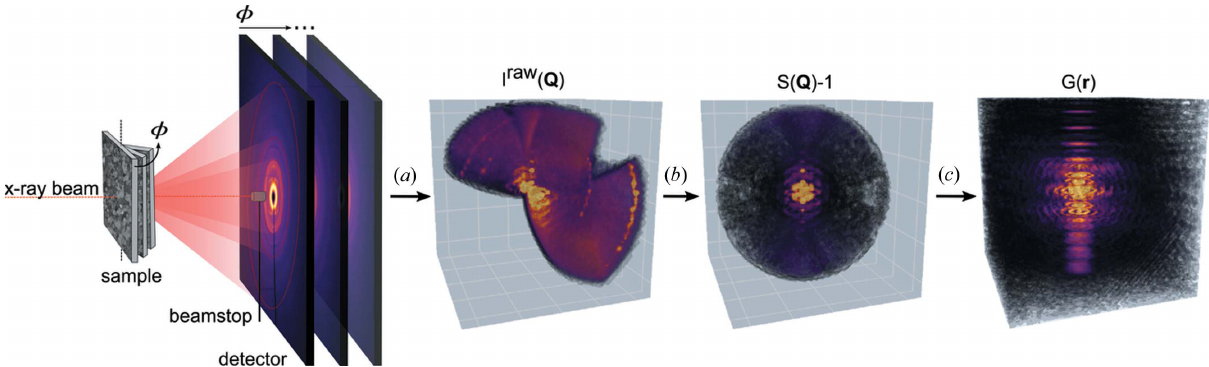
Figure 4 The experimental and data-processing procedure. ( a ) Reconstruction of a tilt series of 2D scattering images to a 3D scattering volume I ( Q ). ( b ) Processing to the total scattering structure function S ( Q ), with application of symmetry averaging, interpolation, and cutoff beyond Q min and Q max . ( c ) Fourier transformation to the txPDF G ( r